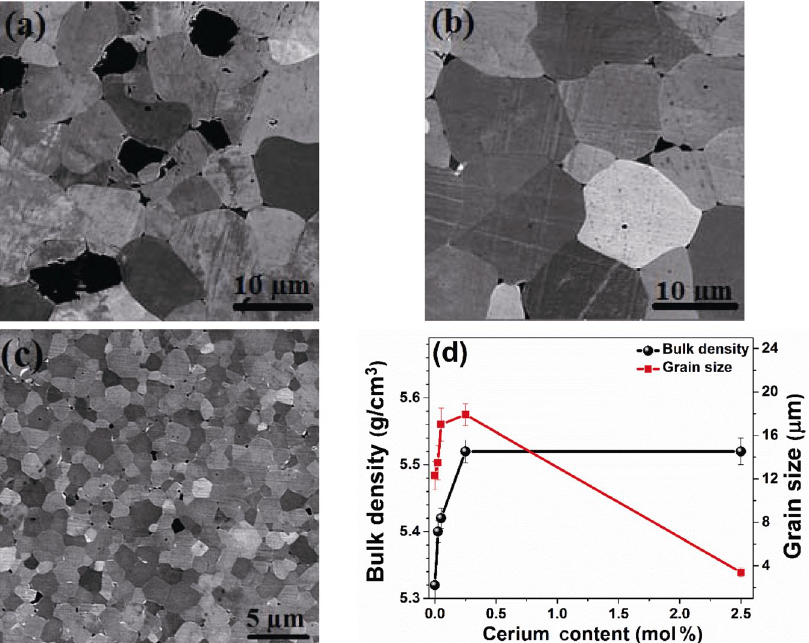
Fig. 4 SEM micrographs of polished non-etched samples with (a) 0, (b) 0.05, and (c) 2.5 mol% Ce. Micrographs were taken using backscattered electrons and orientation-contrast imaging, therefore different gray levels represent different grain orientations. (d) The influence of the Ce content on the density for the samples sintered at 1350 ℃ for 4